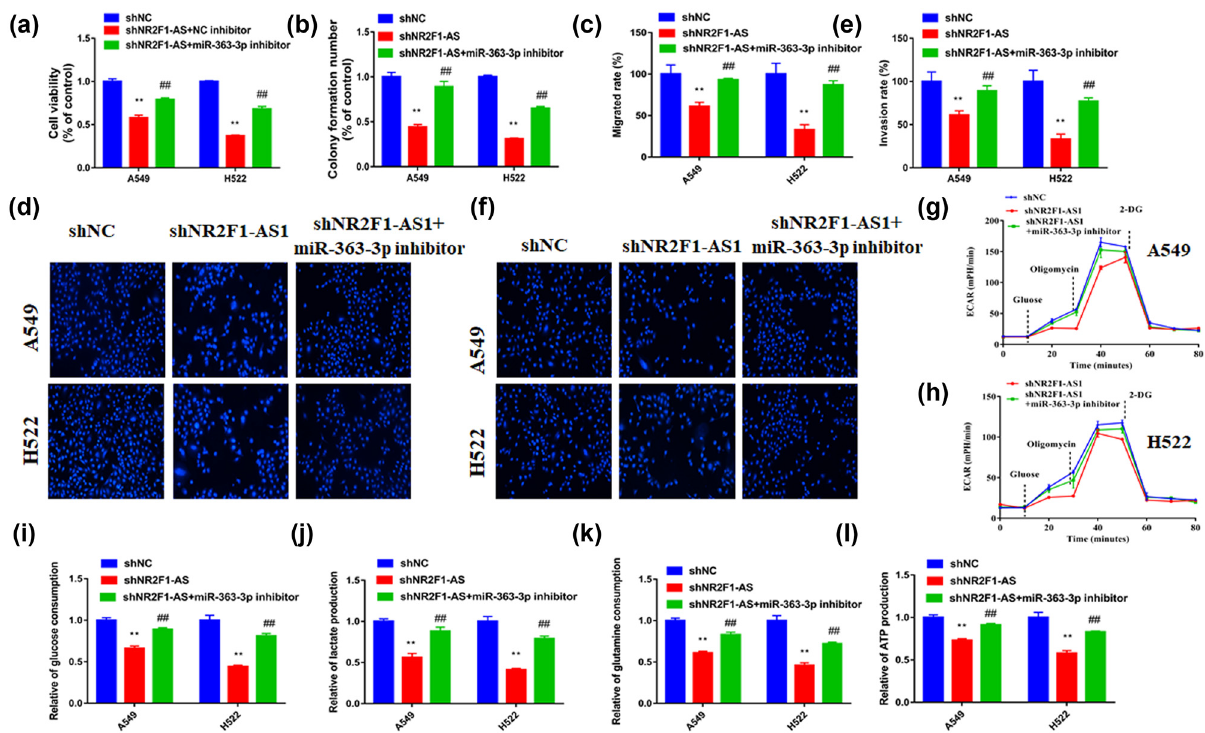
Figure 5: NR2F1 - AS1 promoted NSCLC progression via sponging miR - 363 - 3p. A549 and H522 cells were transfected with sh - NC, sh - NR2F1 - AS1, sh - NR2F1 - AS1 + anti - miR - NC, or sh - NR2F1 - AS1 + anti - miR - 363 - 3p. The ( a ) viability, ( b ) colony number, ( c and d ) migration, and ( e and f ) invasion of cells were determined using CCK8 assay, colony formation assay, and transwell assay. ( g and h ) Cell glycolysis, ( i ) glucose consumption, ( j ) lactate production, ( k ) glutamine consumption, and ( l ) ATP production were evaluated by the corresponding assay, respectively. ** P < 0.01 compared with the sh - NC group. ## P < 0.01 compared with sh - NR2F1 - AS1